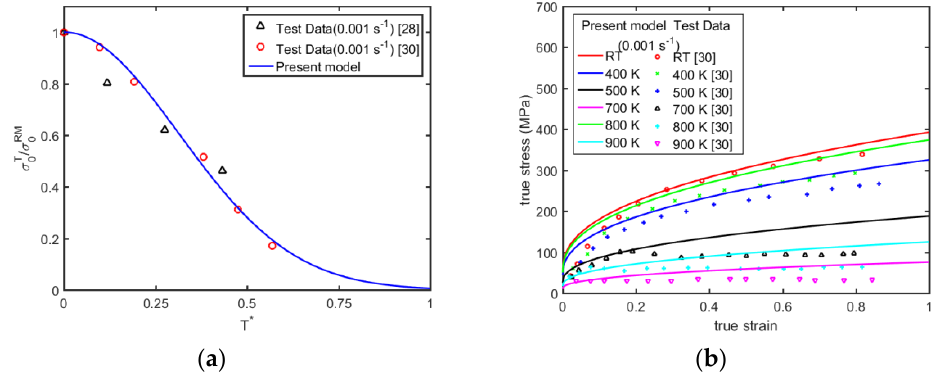
Figure 10. Comparison of the present model predictions with the compression test data for OFHC copper. ( a ) σ 0 T / σ 0 Ta versus T * at a plastic strain of 0.15 under strain rate of 0.001 s − 1 ; and ( b ) true stress-true strain curves at elevated temperatures.